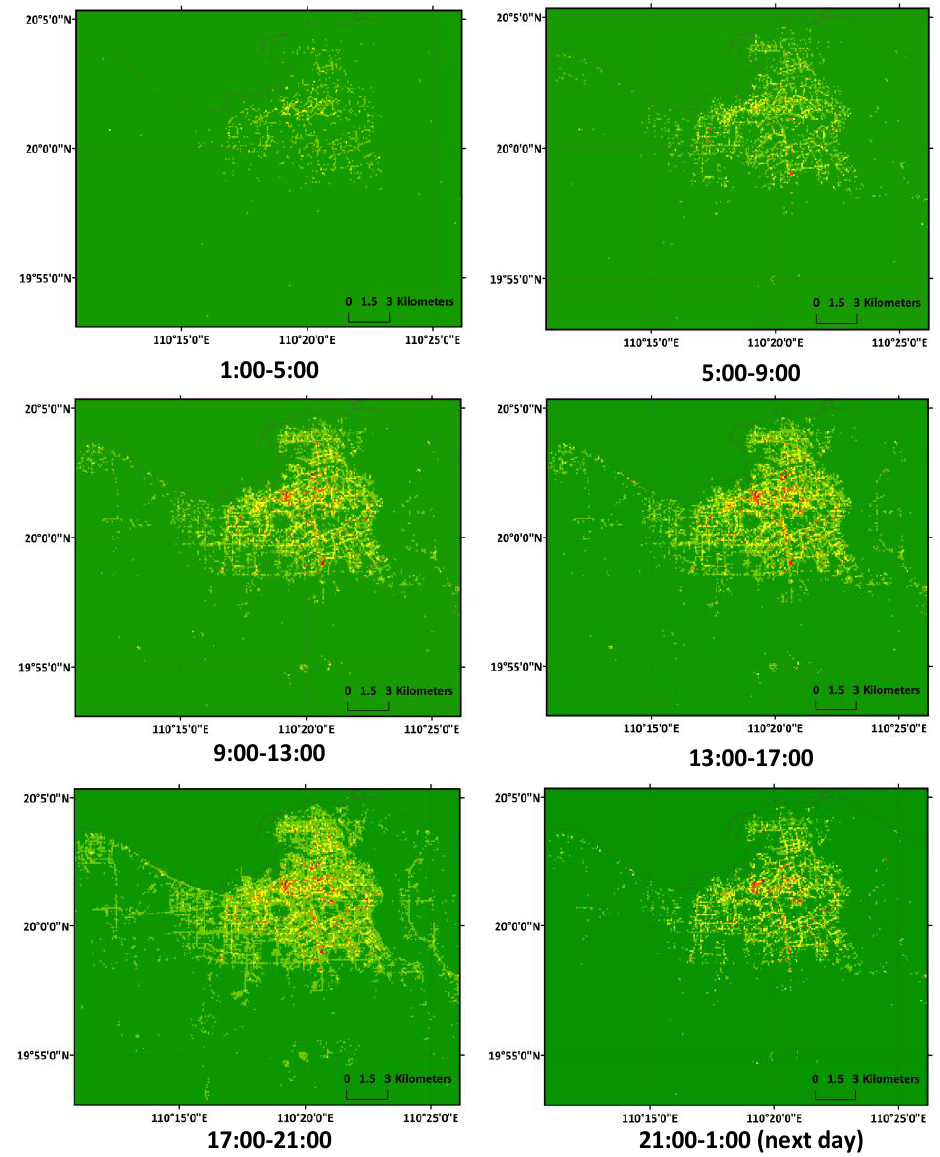
Figure 3. One–day heat map of collective mobility taking taxi. Set the sampling interval as 4 h, the brighter the color, the higher the mobility of people in that spatial–temporal geogrid.